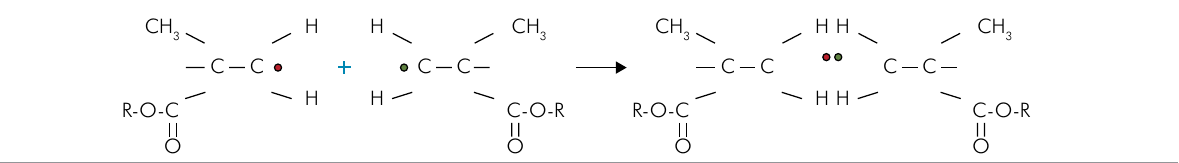
Figure 5. Diagram of chain termination via monomer-radical